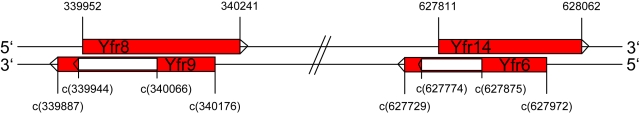
Gene arrangement of ncRNA pairs Yfr8/Yfr9 and Yfr6/Yfr14.Potential peptide-coding open reading frames within the sequence of the RNAs are shown as white boxes. Positions in the genome are indicated by numbers for the forward and reverse (c) strand.